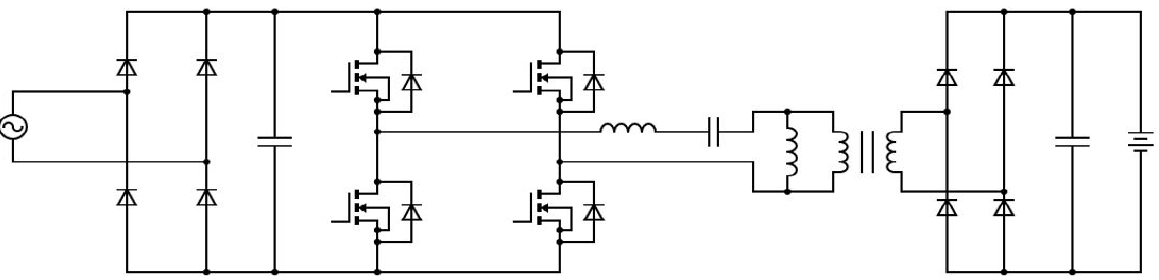
Figure 10. Two-stage charger with Cuk converter front-end and half-bridge LLC back-end [21].